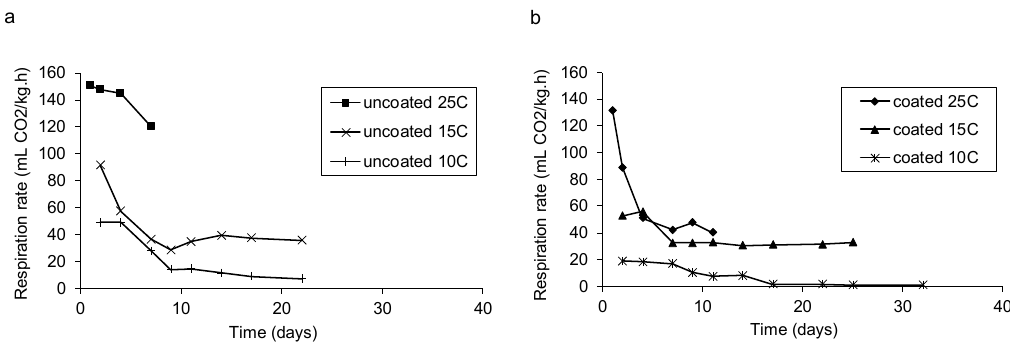
Figure 3. Respiration rate of ( a ) uncoated and ( b ) coated limes at different temperatures.